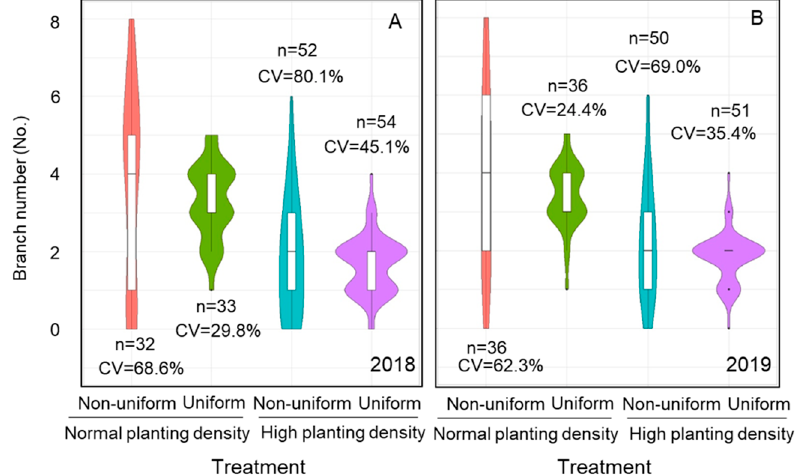
Figure 5. Effect of plant distribution on soybean branch number during the 2018 ( A ) and 2019 ( B ) growing seasons under different planting densities. CV, coefficient of variation.